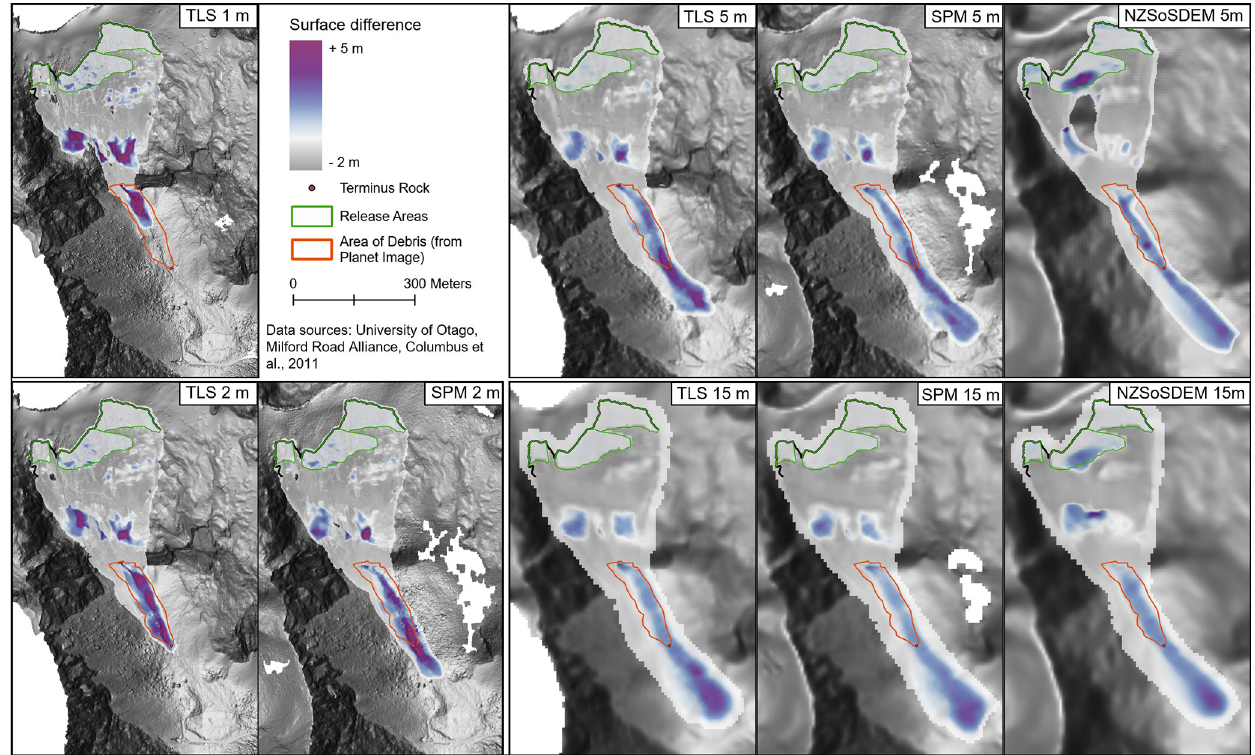
Figure 7. Composite of simulation outputs for TLS, SPM and NZSoSDEM DSMs showing surface difference areas of estimated erosion and deposition. Outputs are grouped by resolution. The fracture line, release areas and debris area are shown in each map. The event was calibrated on the TLS 2m DSM.